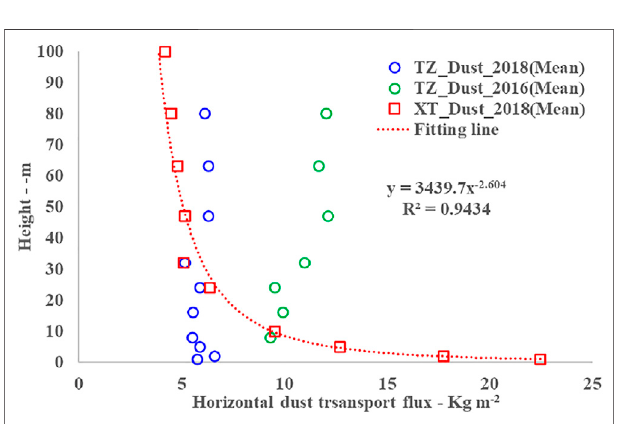
FIGURE 4 | Comparison of the variations in horizontal dust fl ux with height in 2016 and 2018.